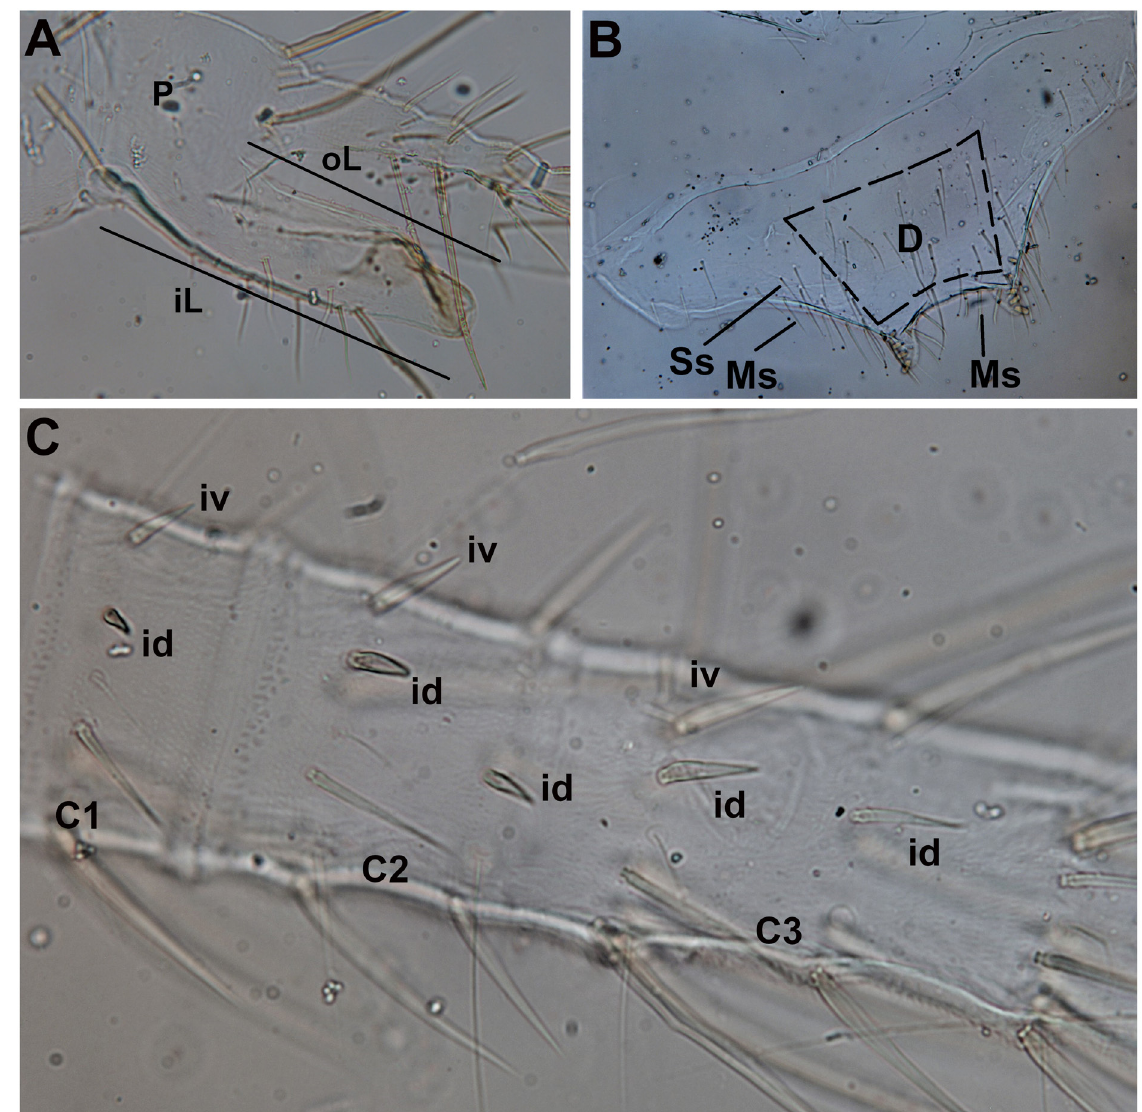
Fig. 1. Characters of taxonomic interest in Coletinia Wygodzinsky, 1980. A–C . Coletinia tinauti Molero, Gaju & Bach, 1997 , holotype. A . Micrographs of a pedicellar apophysis. B . Urotergite X. C . Basal part of the left cercus. Abbreviations: C1, C2 and C3 = first, second and third divisions of the cercus (the limit between the first and the second is better in focus); D = disc of the urotergite; id = spines or pegs inserted inner dorsal position; the first id spine in the C2 has blunt apex and can be considered as a peg; iL = inner length of the apophysis; iv = spines inserted in inner ventral position; Ms = marginal setae; oL = outer length of the apophysis; P = pedicel; Ss = submarginal